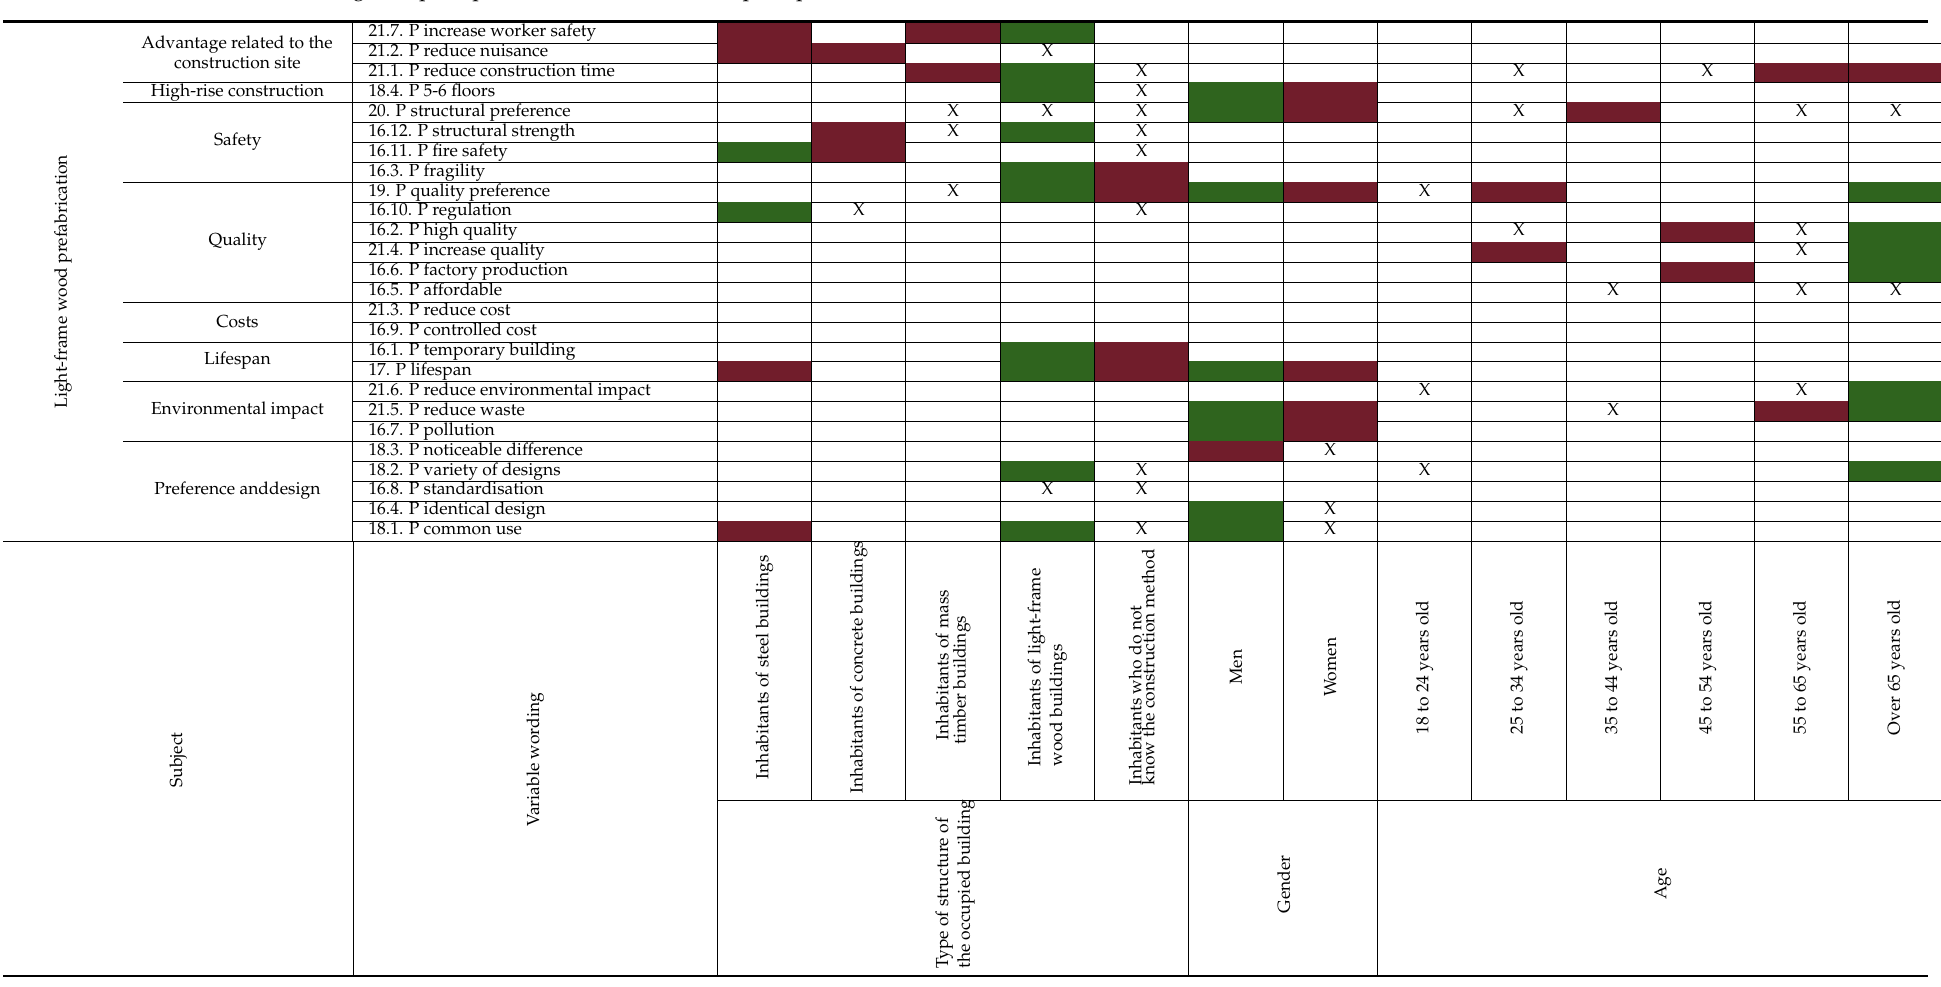
Table 2. Response profile related to respondents’ characteristics regarding light-frame wood prefabrication. Green cells present a positive perception, red cells a negative perception, and X cells a neutral